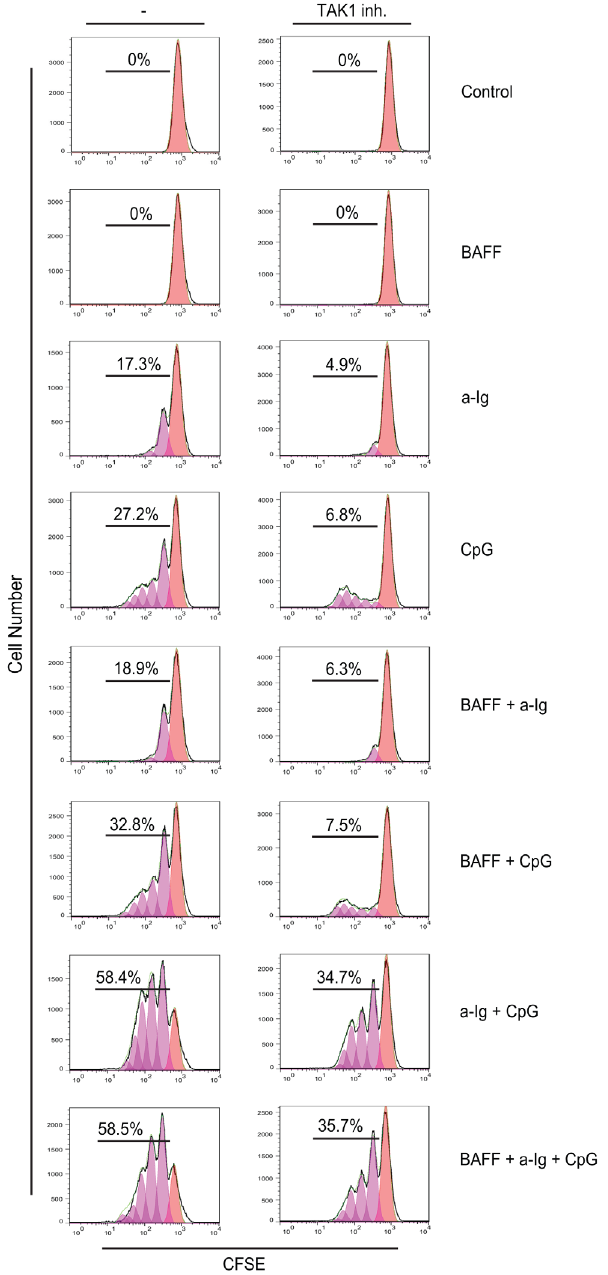
Figure 4. Proliferation of primary human B cells after the combined stimulation with anti-Ig, CPG ODN and BAFF. Representative flow cytometric histograms of CFSE-labeled blood human B cells stimulated with combinations of 2.5 m g\ml anti-Ig, 100 ng/ml BAFF and 2 m g/ml CpG as indicated. Peaks shifted to the left represent cell populations undergoing increasing number of division. Total percentages of dividing cells are shown. The samples were cultured in the presence or absence of TAK1